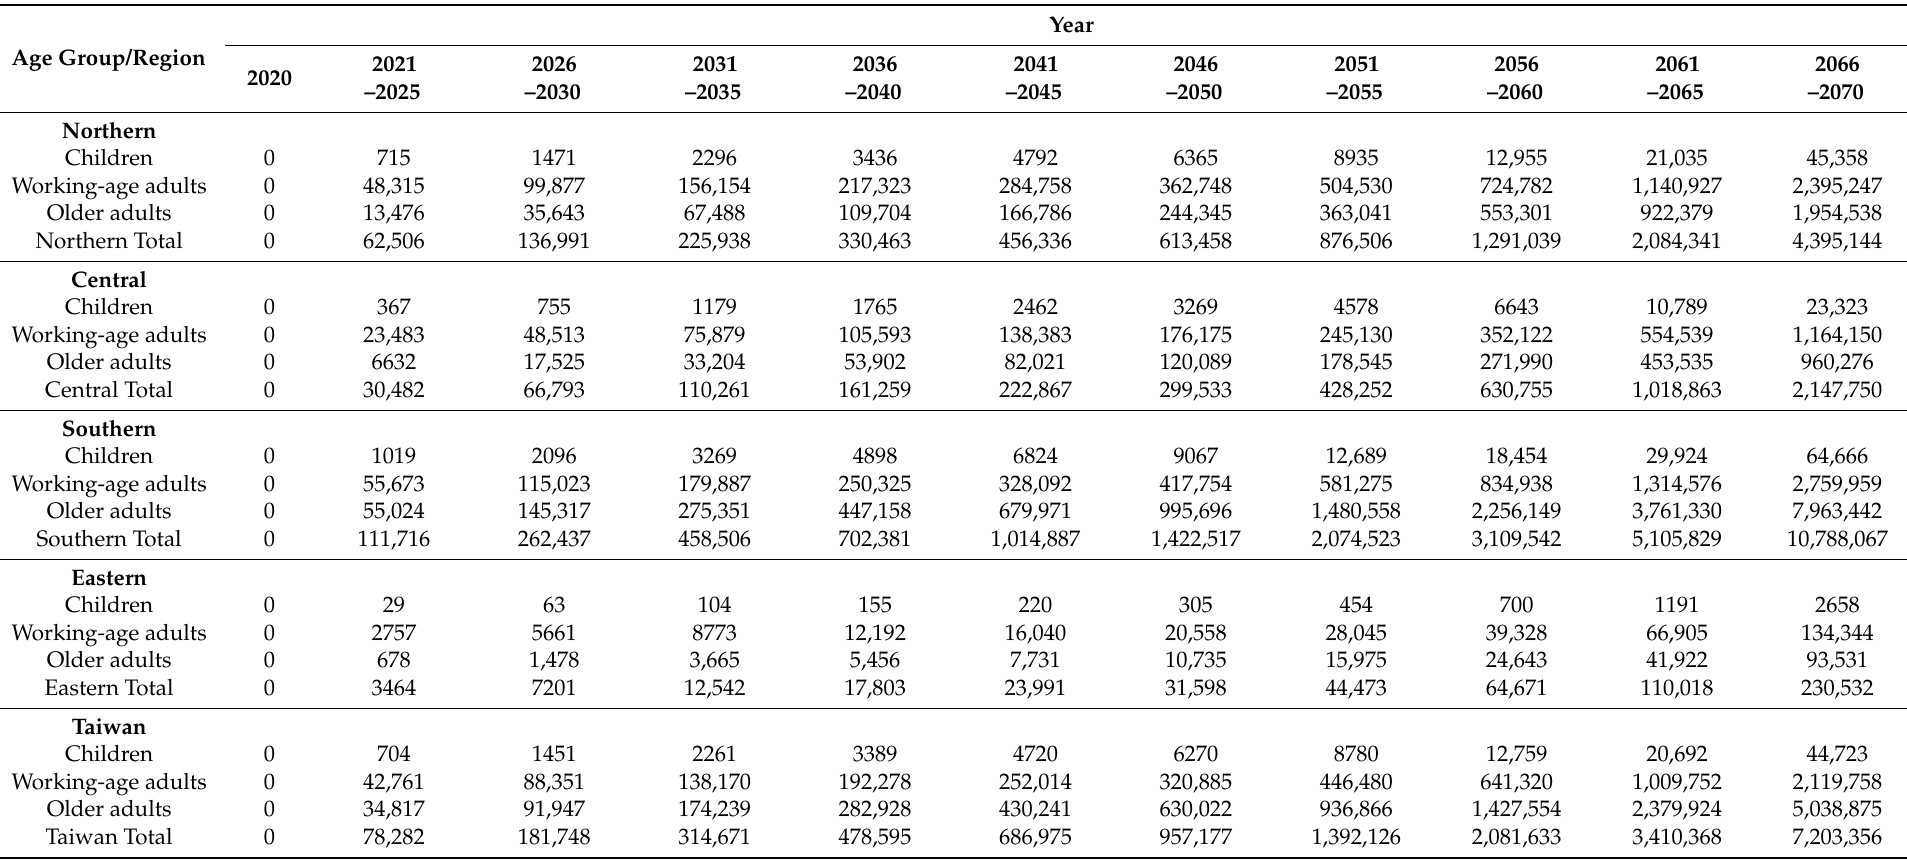
Table 8. Net BPT values of dioxin emissions reduction for different age groups in each region for 2020 and projected values for every 5-year period in 2021–2070